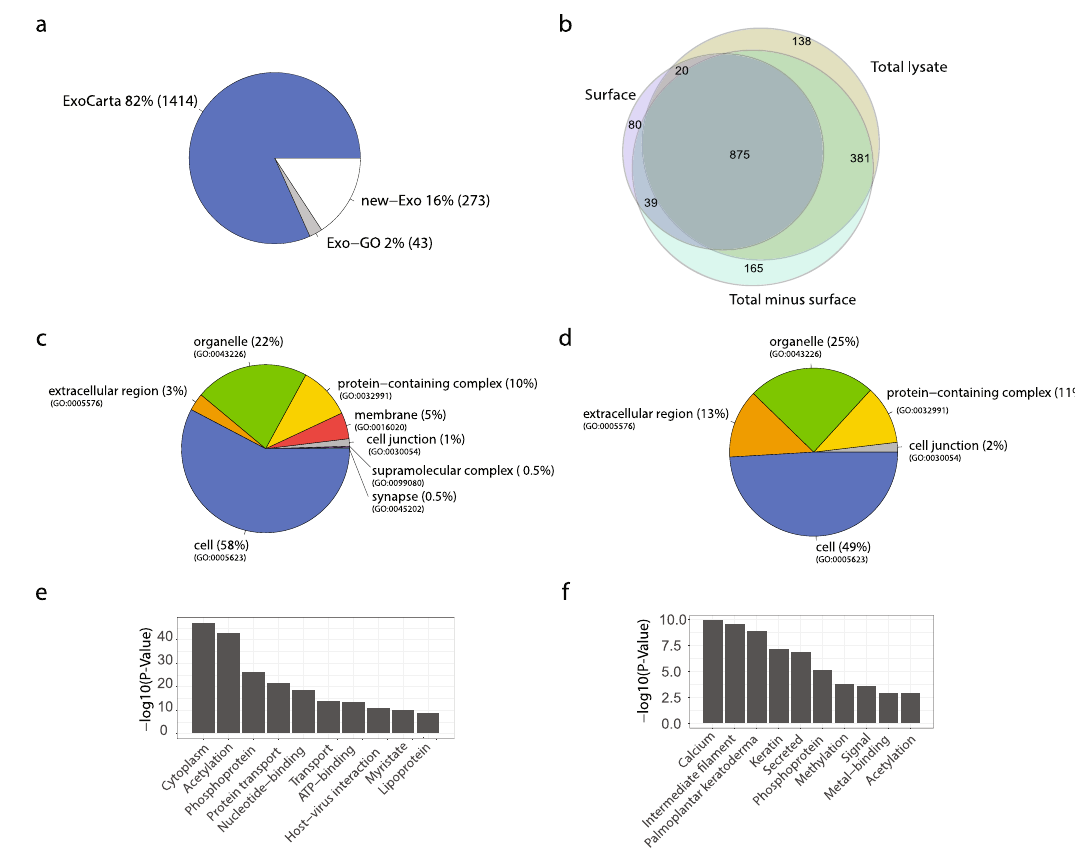
Fig. 3 Global proteomic analysis and GO annotation of SF-sEVs proteins. a Proteins identi fi ed by MS analysis of SF-sEVs and PC3 sEVs were compared against the ExoCarta and GO databases. b Venn diagram representation of the proteins identi fi ed in the three SF-sEVs fractions. c Pie chart representation of Gene Ontology Cellular Component categories (GO-CC) for proteins enriched in total minus surface. d GO-CC categories for proteins enriched in surface fractions. e Top ten terms obtained by functional annotation analysis in DAVID for proteins enriched in total minus surface fractions. f Top ten terms identi fi ed in DAVID for proteins enriched in surface fractions. Only proteins identi fi ed in at least two samples were included in the